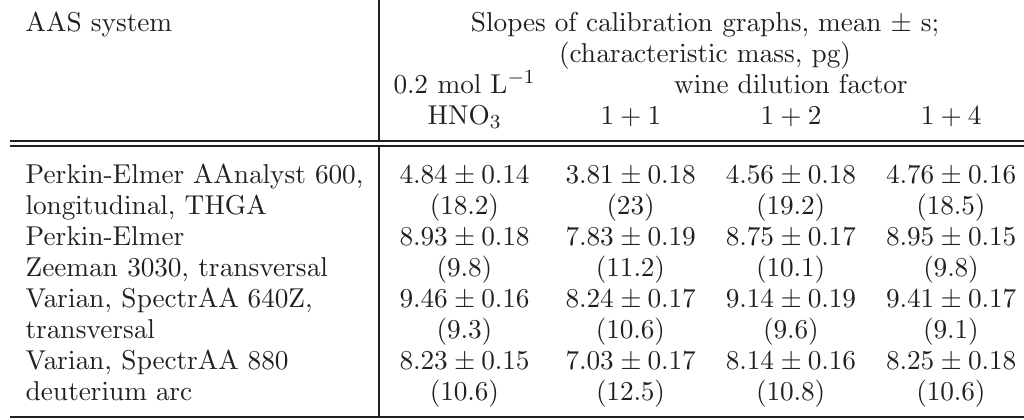
Table 2 The slopes of calibration graphs obtained in the presence of 0.2 mol L − 1 HNO and in the presence of red wine, using different dilution factors, n = 3.